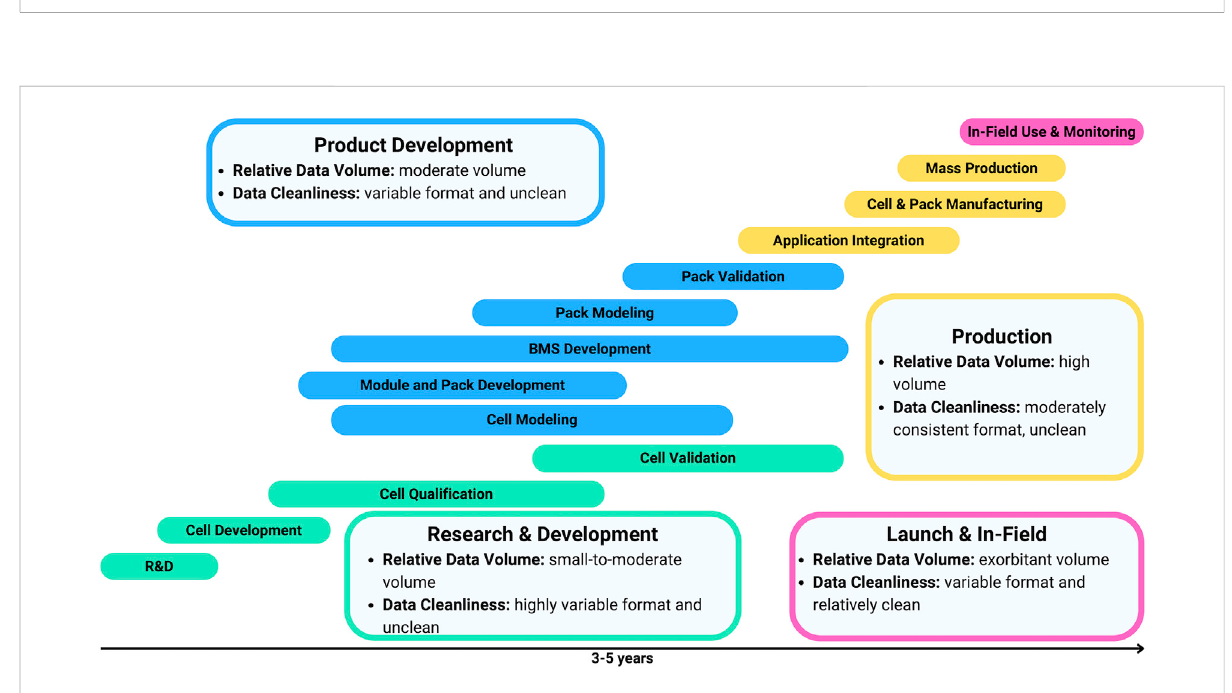
FIGURE 2 Graphical representation of the primary stages in the battery lifecycle, de fi ned in part by the differences in data collected at each